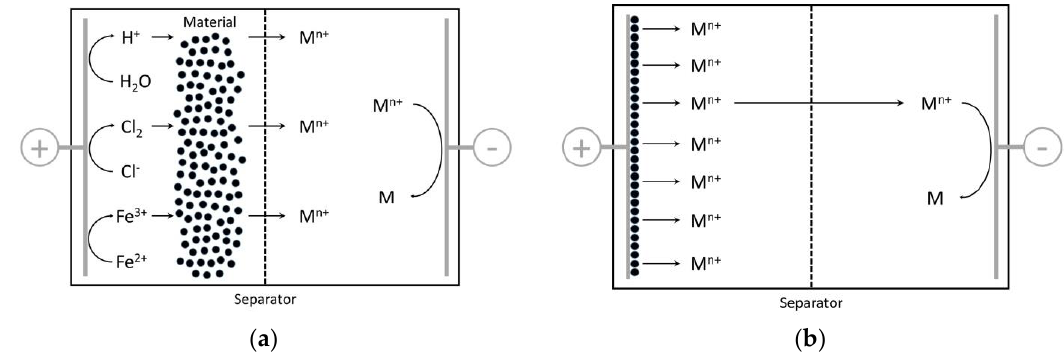
Figure 1. Scheme of the coupled electro-assisted leaching electrodeposition ( a ) and direct Figure 1. electroleaching/electrodeposition ( b ) conducted in a single-cell. electroleaching/electrodeposition ( b ) conducted in a single-cell.